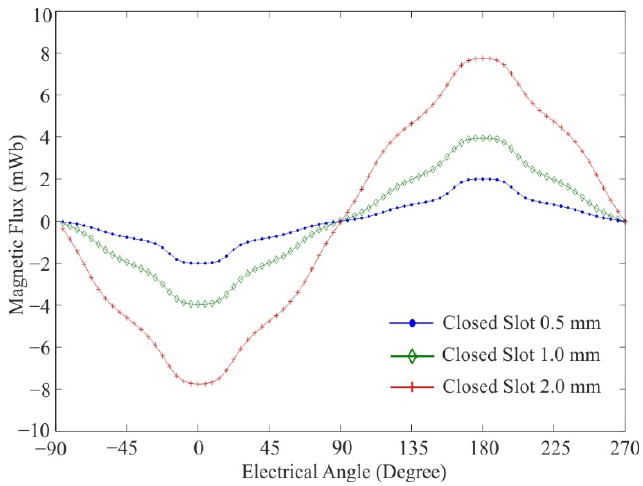
Figure 9. Magnetic flux through the closed slot at a thickness of 0.5 mm (dot), 1 mm (diamond) and 2 mm (cross), simulated over one magnetic pole pair.